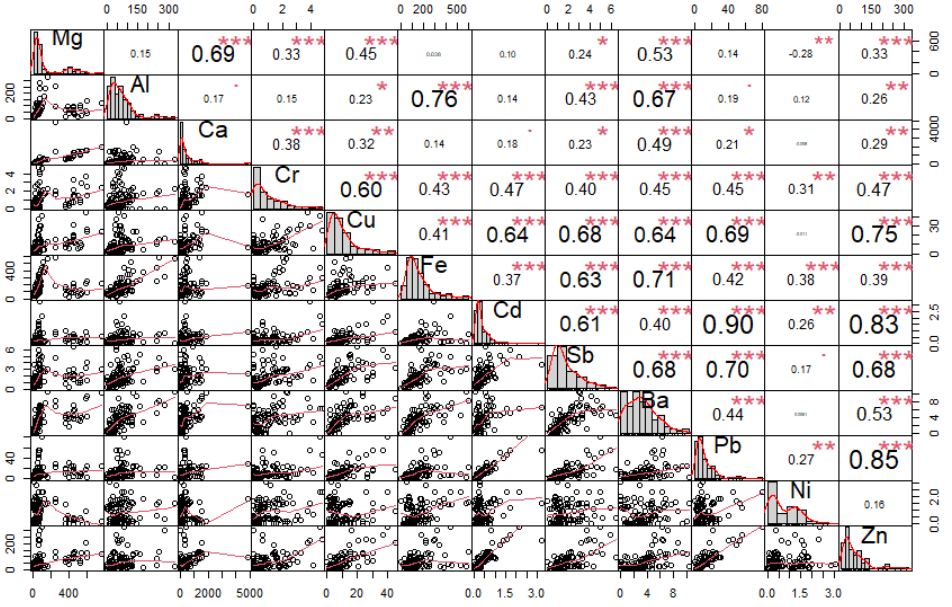
Figure 5. Correlation matrix of elements found in the PM 2.5 fraction from measurements taken in the city of Žilina ( p -values (0, 0.001, 0.01, 0.05, 0.1, 1) <=> symbols (“***”, “**”, “*”, “.”, “ “)).